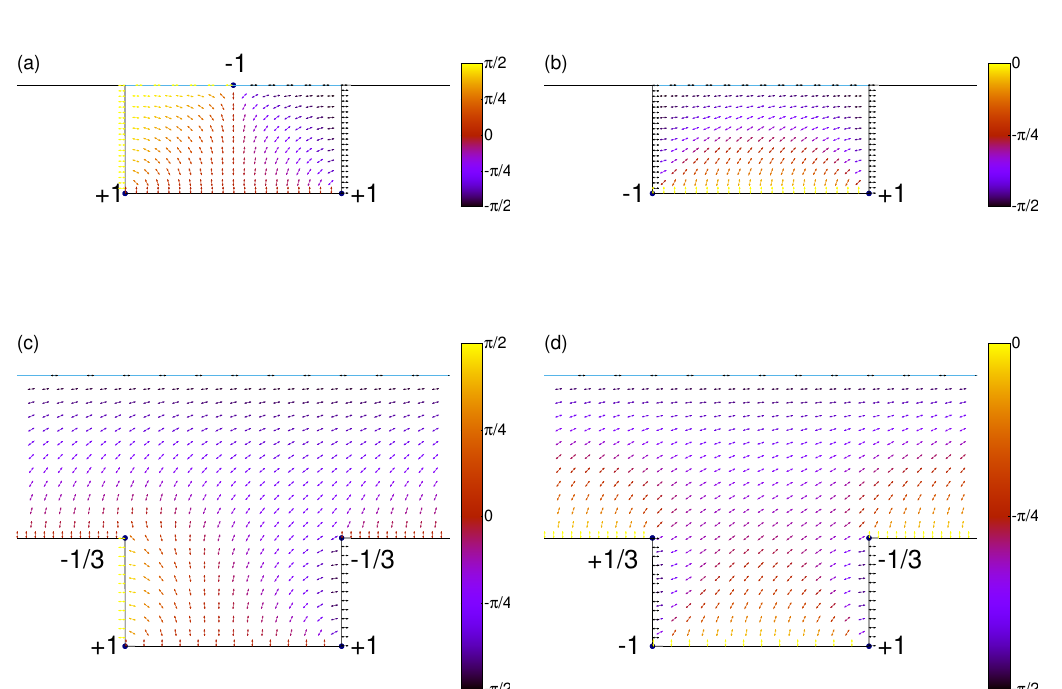
Figure 2. Typical filled and wet textures at a crenellated substrate ( h / l 2 = 0.5, l 1 / l 2 = 1): ( a ) the symmetric filled state F s texture; ( b ) the asymmetric filled state F a texture; ( c ) the symmetric wet state W s texture; and ( d ) the asymmetric wet state W a texture. The blue line corresponds to the position of the nematic isotropic interface, and the director field is colored by the angle θ of the local nematic director with respect to the y axis. Circles locate the director field singularities or disclinations and are labeled by their topological charges.